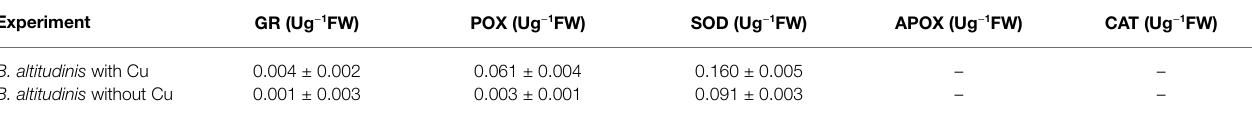
TABLE 1 | Expression of antioxidative enzymes of Bacillus altitudinis MT422188 with and without Cu.